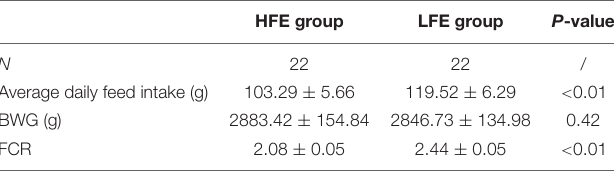
TABLE 1 | Descriptive statistics of